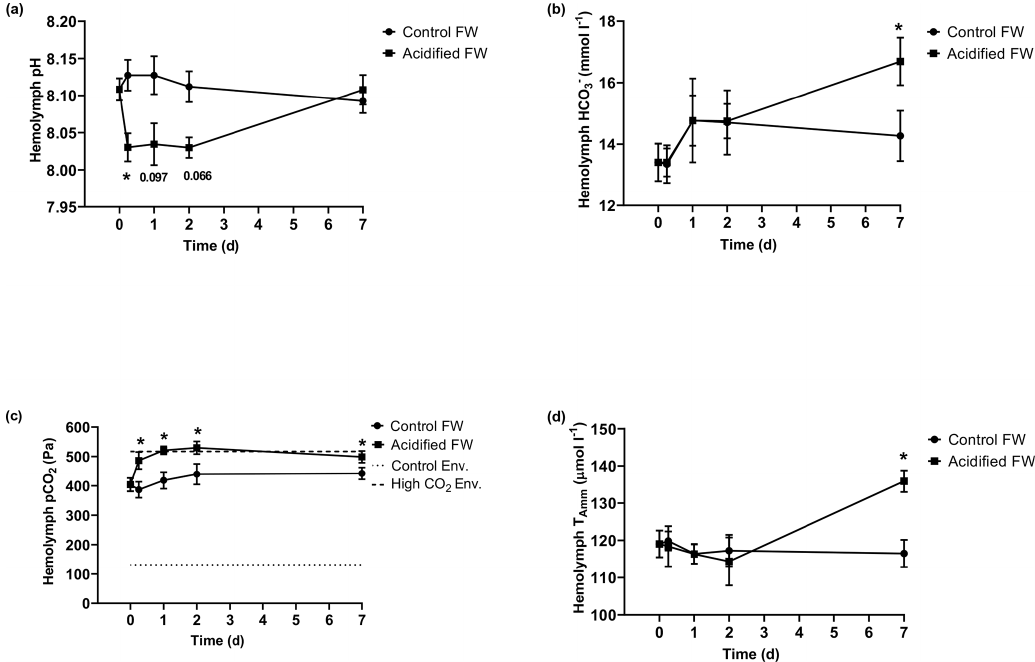
Figure 2. Changes in extracellular (a) pH, (b) HCO − , (c) p CO 2 , and (d) ammonia of juvenile Chinese mitten crabs, Eriocheir sinensis , 3 during a 7d time course of exposure to control (pH 7.41, 1299µatm p CO 2 ) or CO 2 -acidified (pH 6.73, 5109µatm p CO 2 ) freshwater. Data are presented as mean ± SEM. ( N = 6–14, 2–3 crabs pooled per N value). Statistical significance was assessed by two-way ANOVA followed by a post hoc Dunnett test with ∗ indicating significant difference from day zero measurements. p values near but not < 0 . 05 are written above the corresponding data point.